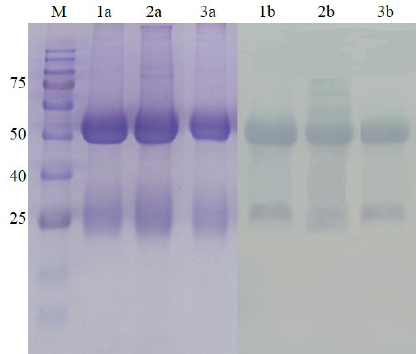
Figure 3. SDS-PAGE ( A ) and Western blot ( B ) shows two IgG bands, heavy chain at 50 kDa and light chain at 25 kDa using 12% separating gel. Lane 1: standard IgG from rabbit, Lane 2: purified Nter IgG. Lane 3: purified Cter IgG. Each lane was loaded with 20 μg/mL of protein.